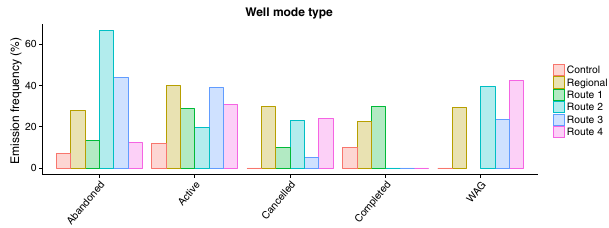
Figure 6. Emission frequencies for each well mode type for all sur- veyed wells on each route. These emission frequencies were con- sidered in our total emissions inventory calculations.